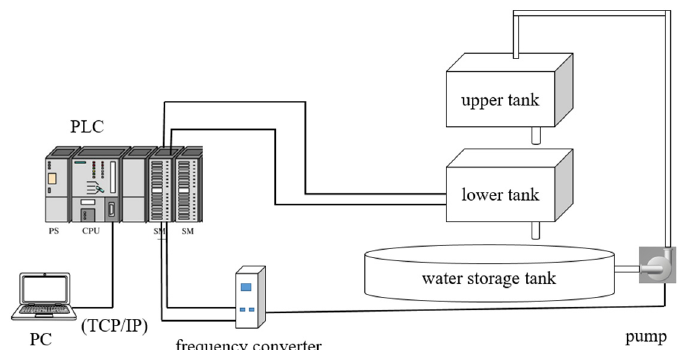
Figure 3. Experimental Schematic Diagram.